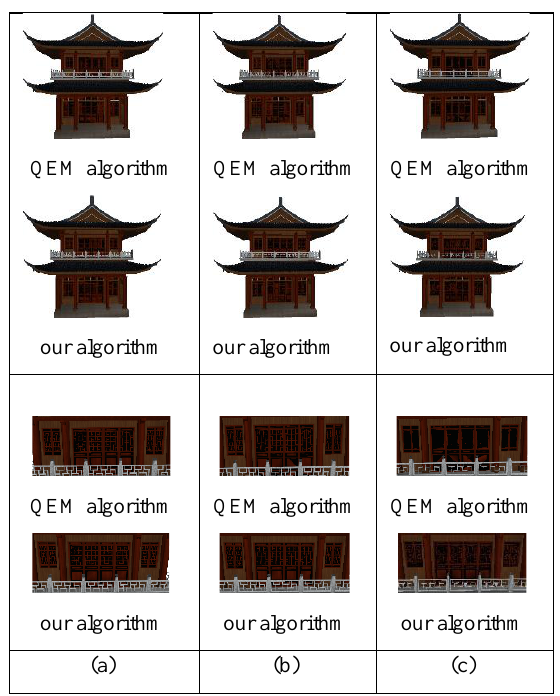
Figure 4 . Simplified results using the QEM algorithm and our algorithm: (a) The simplification rate is 25% (b) The simplification rate is 50% (c) The simplification rate is 75%